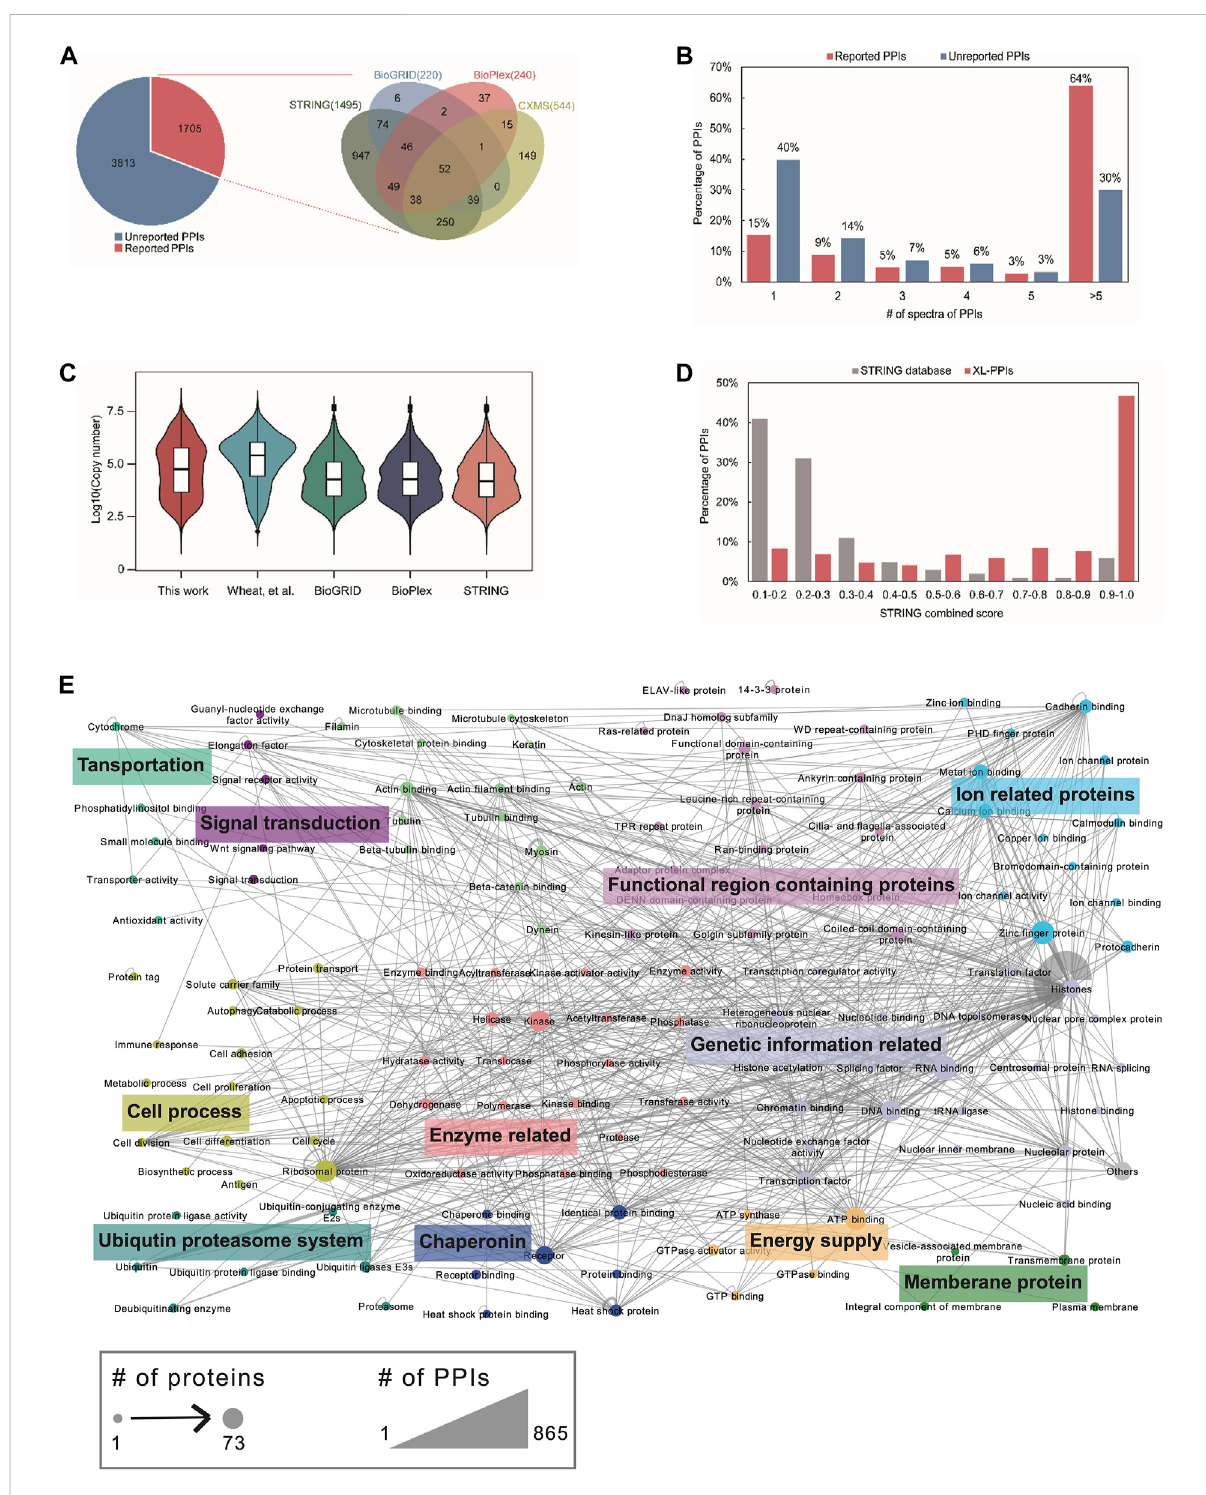
FIGURE 3 Protein – protein interaction analysis. (A) Overlap of our identi fi ed PPIs with the existing PPI databases of STRING, BioGRID, BioPlex, and referenced cross-linking databases. (B) Distribution of the number of spectra between reported PPIs and unreported PPIs. (C) Copy number distribution of the interaction proteins among different protein interaction databases. Protein copy numbers are from the study of previous study (Bekker-Jensen et al., 2017). (D) Comparison of STRING-score distribution between the identi fi ed PPIs and all the human PPIs in the STRING database. (E) Proteininteractionnetworkmappedbytheidenti fi edcross-linkedproteins.Thenodesarecolorcodedbasedonproteinfunctions.The sizeofthenodesisproportionaltothenumberofproteinsincludedinthecorrespondingclassi fi cation.Thicknessofthelinesrepresentsthenumber of protein